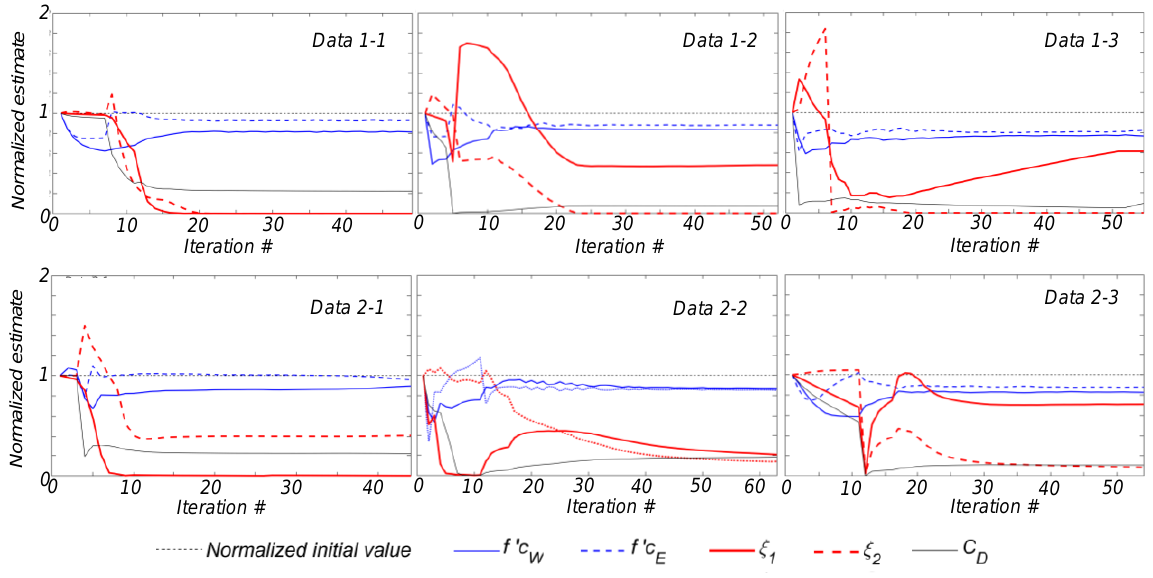
Figure 11. Updating process for the posterior estimates of the unknown model parameters using data in Table 4.